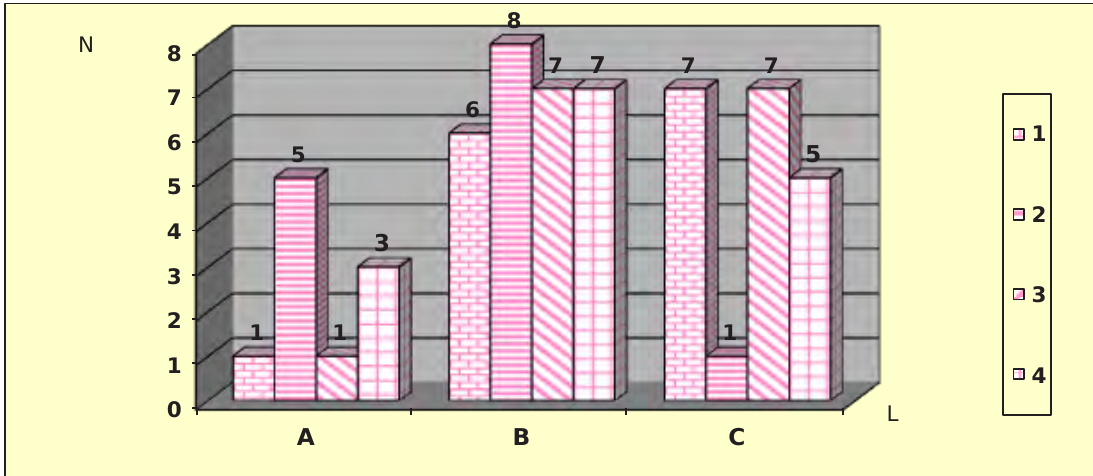
Fig.3. Results of a comparative analysis of EG and CG on the effective score: 1 – EG in the preliminary stage, 2 – EG – at the control stage, 3 – CG in the preliminary stage, 4 – CG – at the control stage, A – high level, B – average level, C – low level, D – level, N – number. Table 2. The results of the pilot study at the preliminary and control stages EG CG Parameter levels levels High Average Low High Average